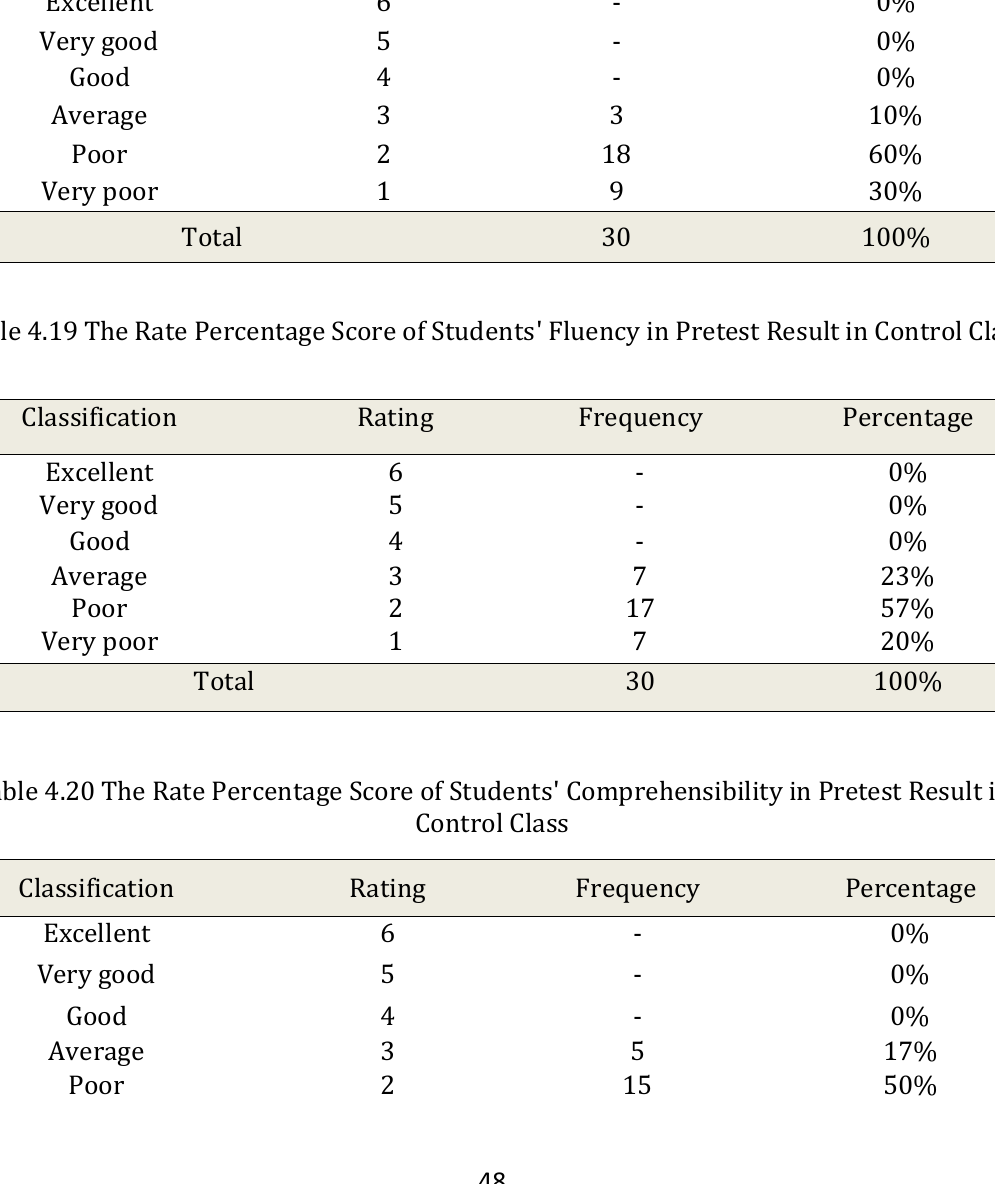
Table 4.18 The percentage Rate Score of Students' Accuracy in Pretest Result in Class Control Classification